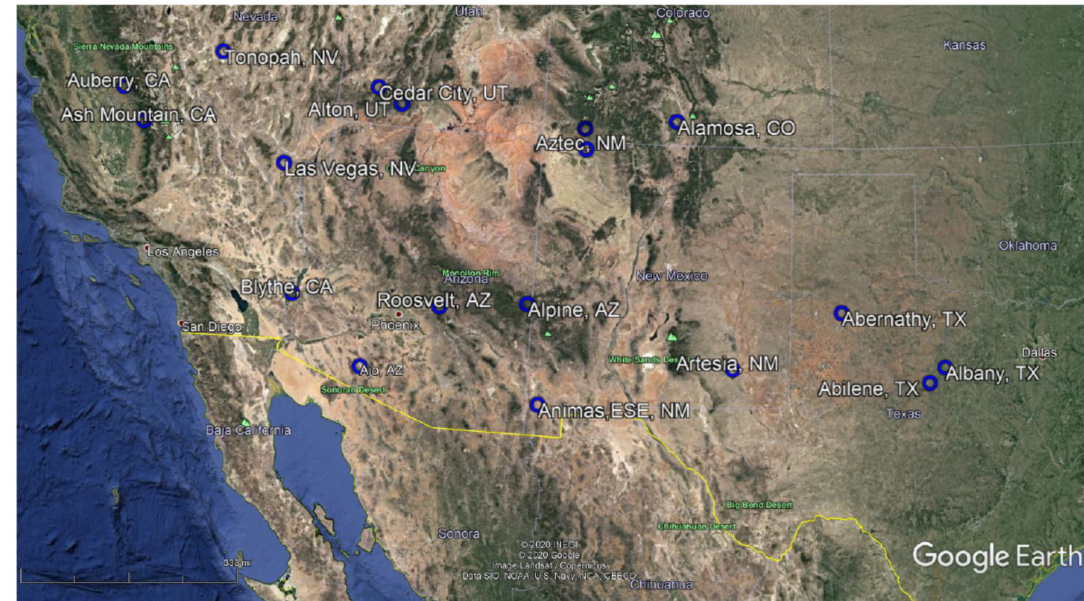
Figure 1. Presentation of the study sites in southwest United States (white dots) (downloaded from Google earth on 28 October 2020). The study sites are marked with the blue circles and the scale is 535.91 km (333